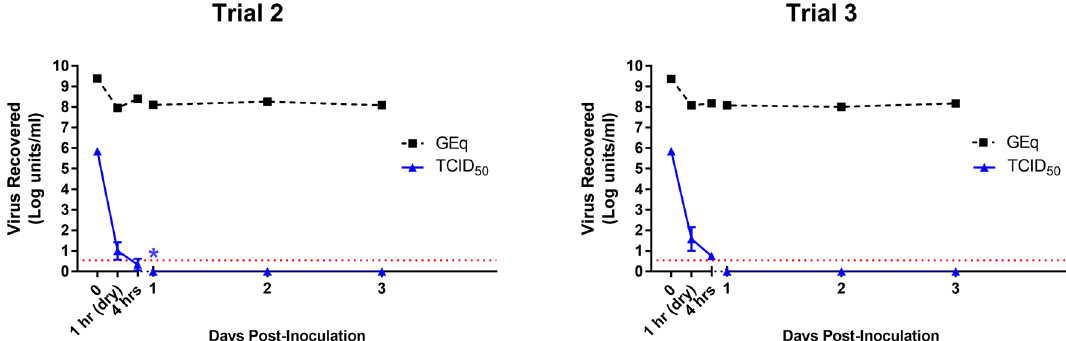
Figure 2. Persistence of SARS-CoV-2 on cotton. Ten microliters of SARS-CoV-2 (titre = 7.88 LogTCID 50 / mL) prepared in a tripartite soil load were inoculated onto gamma-irradiated coupons of cotton fabric and sampled at predetermined intervals over a 3-day time-course. TCID 50 values (solid lines) represent mean ± SD of viable virus recovered from three biological replicates following end-point titration in Vero E6 cells. Genome equivalents (dashed black lines) are based on nucleoprotein-specific qRT-PCR results obtained from pooled eluates of three biological replicates at indicated sampling points. Red dashed lines indicate limits